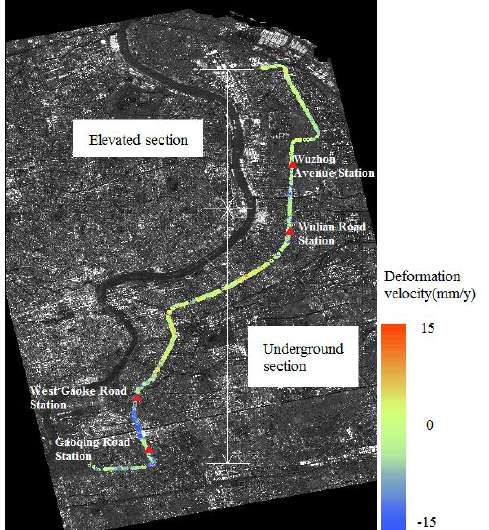
Figure 6. The deformation rate along Shanghai Metro Line 6 by